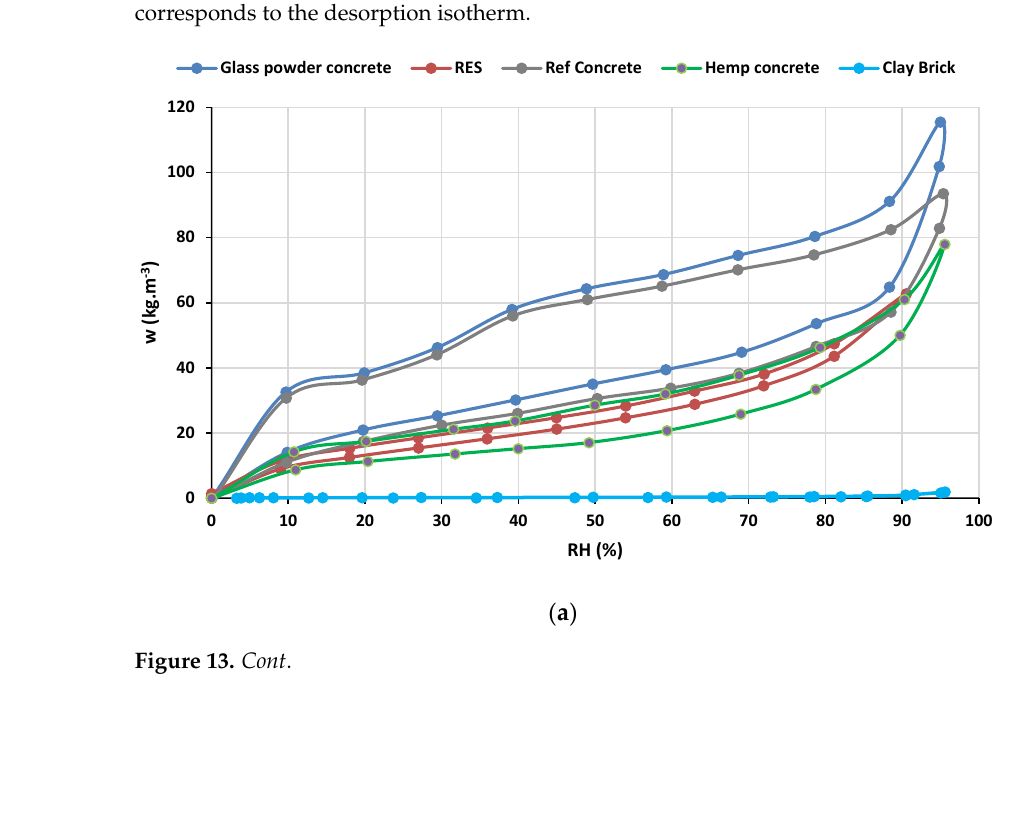
Figure 12. Sorption isotherms of raw earth (RE), raw earth/straw composite (RES) ( a ) and straw (S) ( b ); the lower curve for each formulation corresponds to the adsorption isotherm, while the upper curve corresponds to the desorption isotherm.